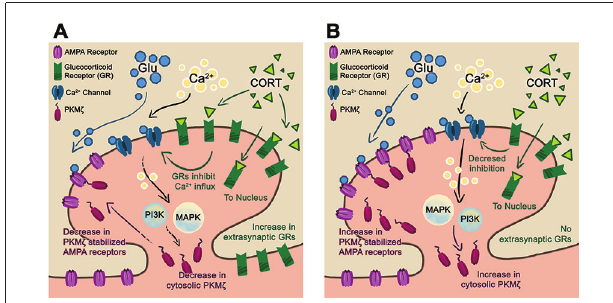
FIGURE 5 | Proposed synaptic model for stress resilience. (A) Schematic of a post-synaptic neuron in the EE-housing condition after chronic + acute stress. In this condition, chronic stress upregulates the extra-synaptic GR that are trafficked into the synapse during the subsequent acute stress. The elevated levels of GR reduce Ca2 + influx and downstream PI3K, and MAPkinase activates reducing PKM ζ /GluA2 trafficking. We hypothesize that maintaining basal levels of synaptic PKM ζ /GluA2 during episodes of stress are beneficial towards preserving synaptic plasticity and memory. (B) In the ST-housing condition, chronic + acute stress does not upregulate GR levels allowing for increased Ca2 + influx and subsequent PKM ζ /GluA2 trafficking. We hypothesize that PKM ζ /GluA2 trafficking during episodes of stress reduce synaptic plasticity and